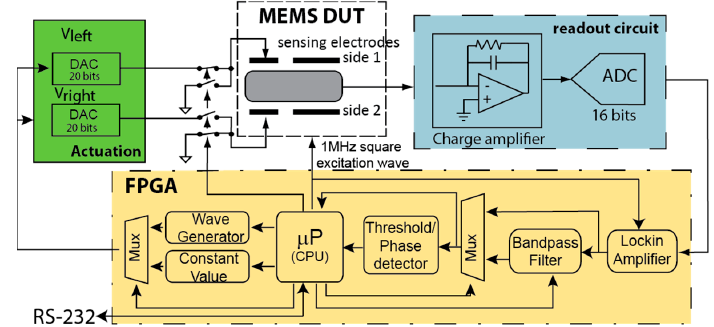
Figure 2. Block diagram of the MEMS test and characterization system, including hardware- and software-embedded blocks. (DUT: device under test; FPGA: Field programmable gate array).